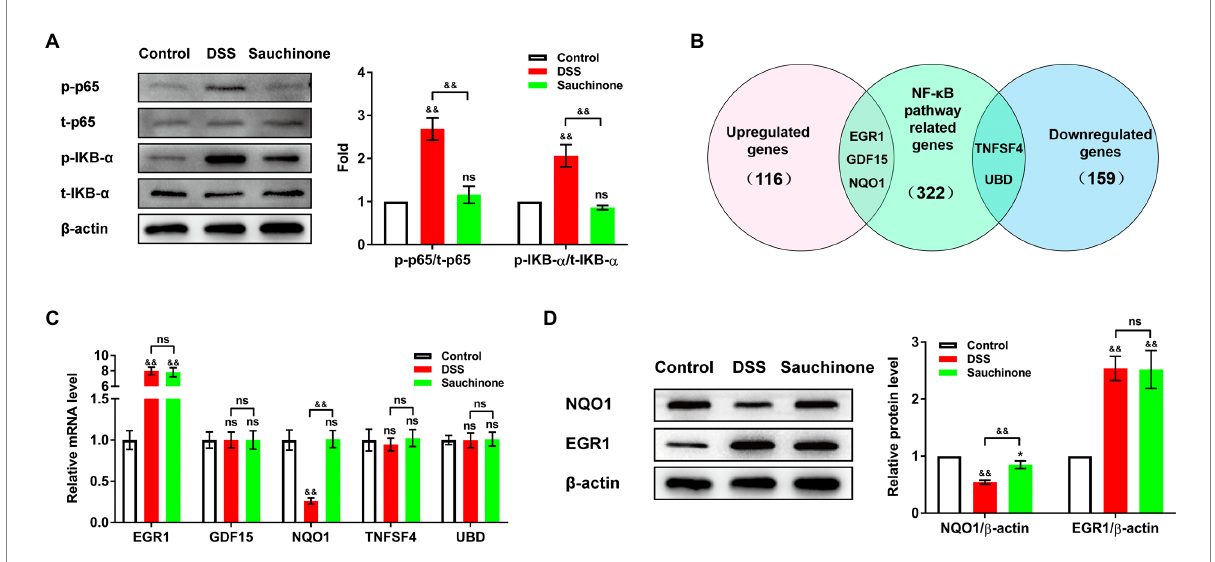
FIGURE 4 Sauchinone regulated the NQO1/NF- κ B pathway in DSS-induced UC mice. (A) The levels of NF- κ B pathway-associated proteins (p-p65, t-p65, p-IKB- α , and t-IKB- α ) were detected by western blot. (B) Predicted target molecules of sauchinone (EGR1, GDF15, NQO1, TNFSF4, and UBD) are displayed in a Venn diagram. (C) Egr1, Gdf15, Nqo1, Tnfsf4 , and Ubd expression levels were detected by qPCR. (D) NQO1 and EGR1 expression levels were detected by western blot. Data are expressed as mean ± standard deviation. * p < 0.05 and && p < 0.01 vs. corresponding control, ns indicates no significant difference; n =